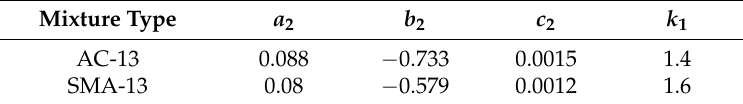
Table 8. Parameters of the linear failure criterions after freeze-thaw cycles.